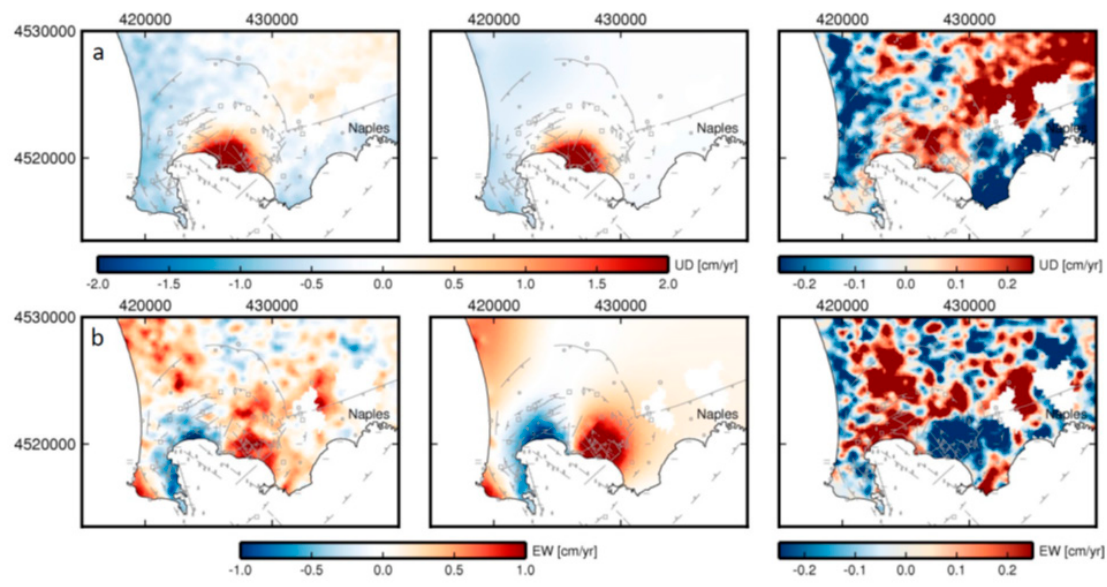
Figure 9. ( a ) Observed vertical displacement rate (left), cm / yr, for the subsidence period, 1999–2000; modelled vertical displacement rate from inversion (center); and residual of observed and modelled displacements (right). ( b ) Observed EW displacement rate (left), cm / yr, 1999–2000; modelled EW displacement from inversion (center); and residual of observed and modelled displacements (right). Images were saturated at the corresponding scales in order to improve comparison and highlight di ff erences among panels [53].